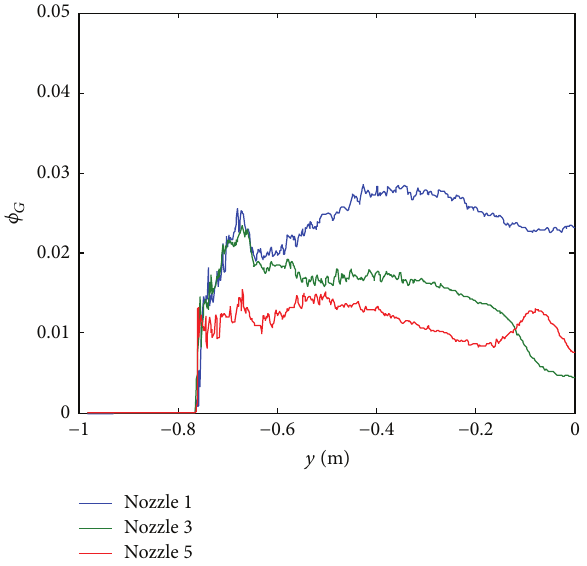
Figure 5: Plot of the volume fraction of